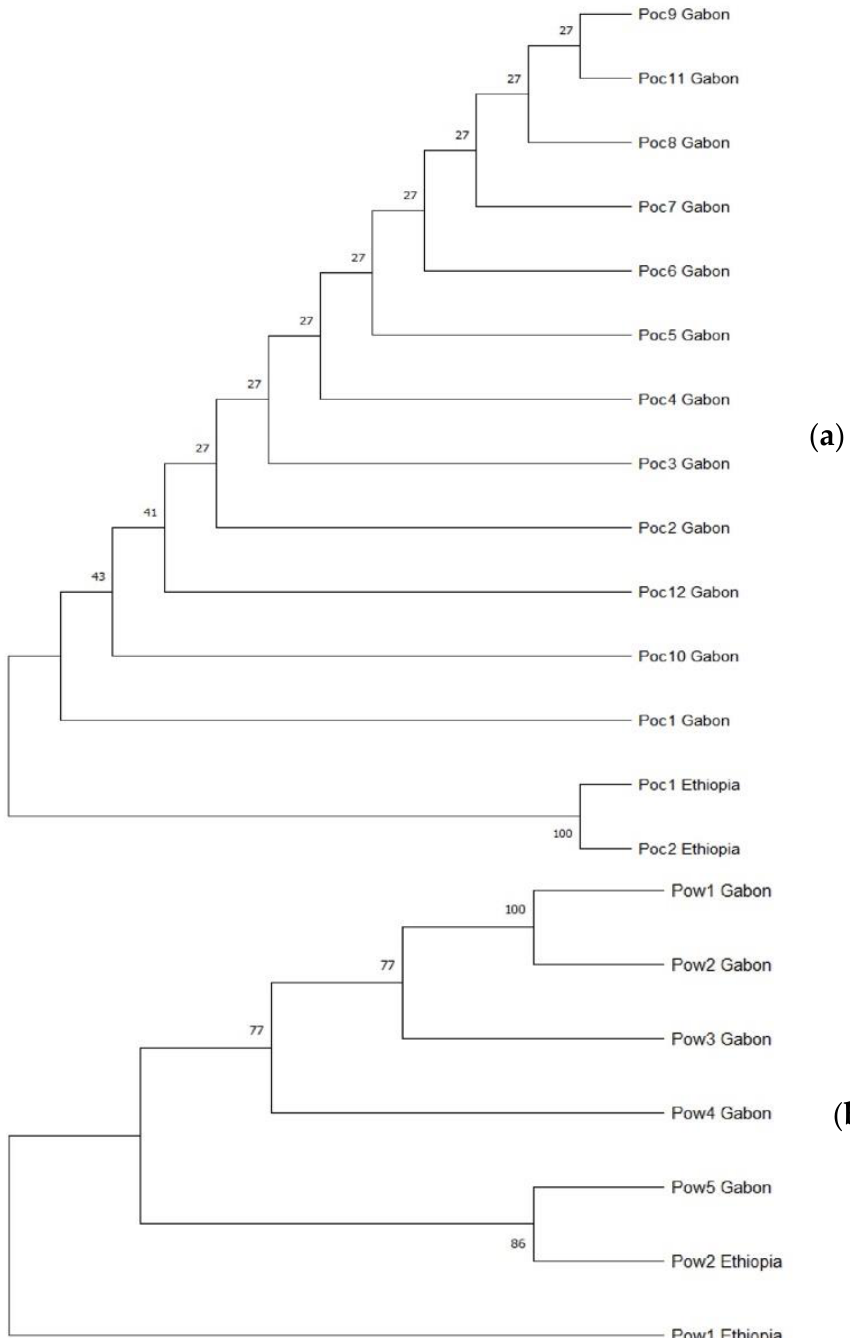
Figure 2. Phylogenetic profile of Plasmodium ovale subspecies from different parts of Africa; profiling with small subunit ribosomal RNA gene of P. ovale curtisi from Gabon and Ethiopia ( a ); profiling with small subunit ribosomal RNA gene of P. ovale wallikeri from Gabon and Ethiopia ( b ).